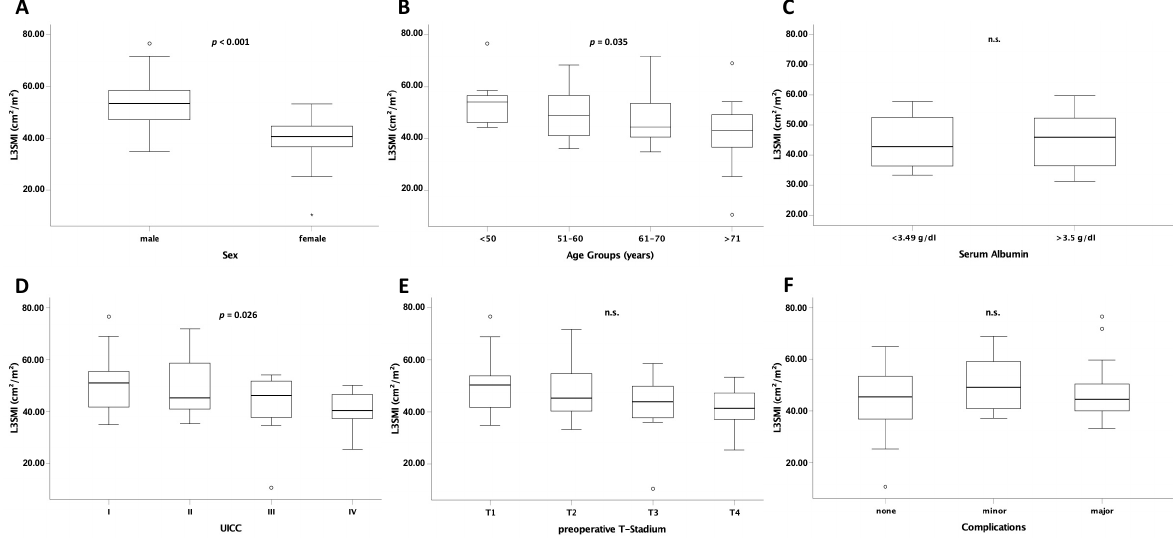
Figure 2. L3SMI is dependent on age, sex, and preoperative UICC stage. L3SMI was significantly different in male and female patients ( A ), different age groups ( B ), and UICC stage ( D ). For albumin serum concentration ( C ), T stage ( E ), and postoperative complications ( F ) no significantly different L3SMI levels were observed. Box plots show medians, quartiles, and ranges; ° = outlier; * = extreme value; n.s. = not significant.